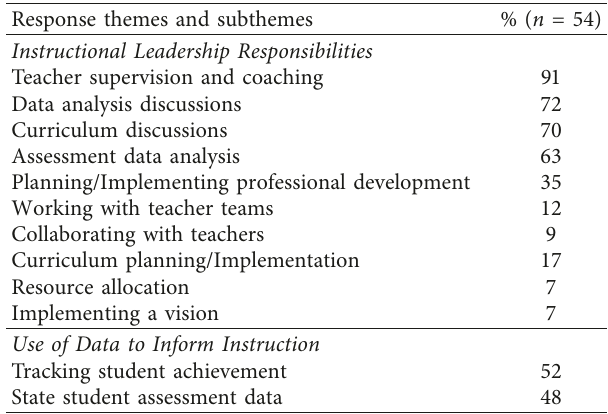
Table 2: Summary of instructional leadership responsibilities re- sponse themes and